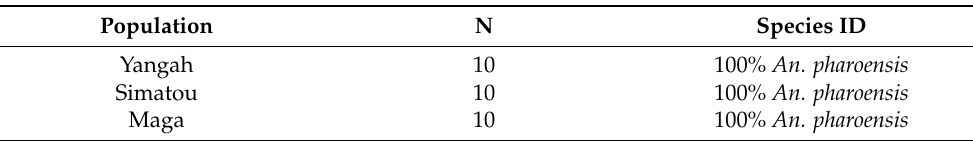
Table 1. Molecular identification of An. pharoensis from the Yangah, Simatou and Maga populations after amplification of COI and COII